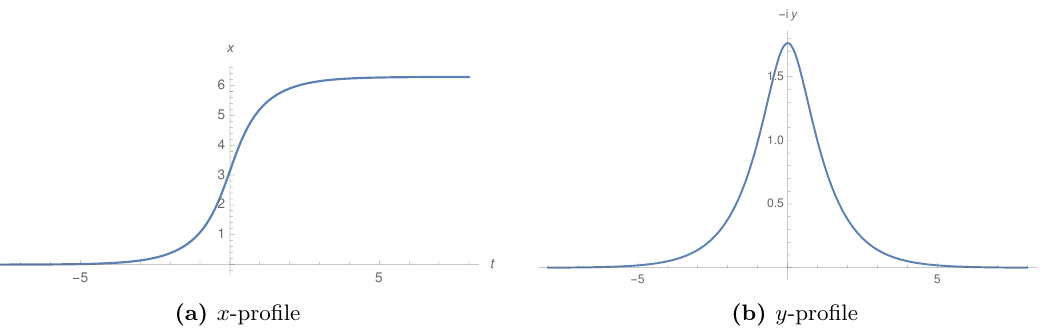
Figure 2. The x - and y -pro(cid:12)les of 1-instanton in the Harper-Hofstadter model. The value of y is purely